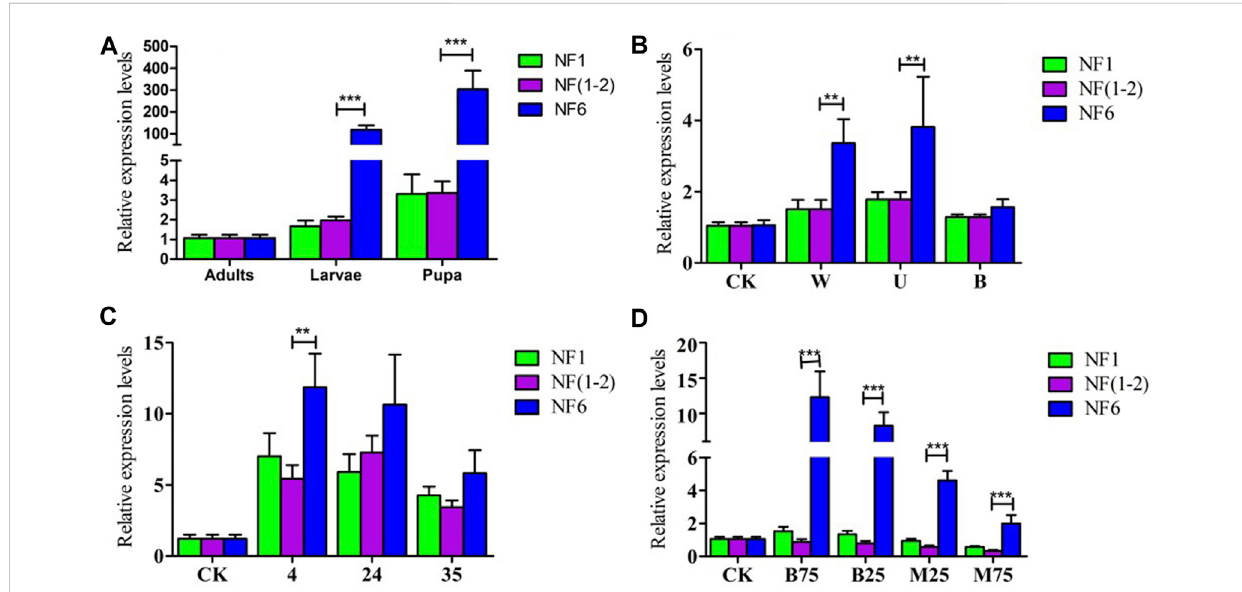
FIGURE 7 Relativeexpressionlevelsofatargetgeneofinterest(CYP450)werecalculatedusingdifferentsetsofreferencegenes. (A) Differentexpressionlevels in three developmental stages, (B) different expression levels in three different light treatment, (C) different expression levels in varying temperature treatments, (D) different expression levels in varying insecticide treatments. The data represent the mean values ± SD. Bars represent the means and standard deviations of three biological